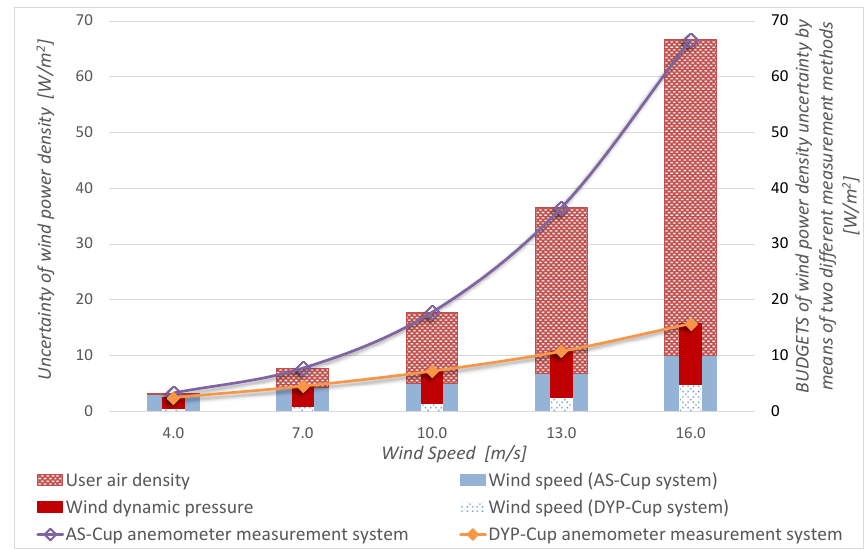
Figure 11. Power density uncertainty budget by means of “power density equations based on wind speed” (AS-Cup, conventional method) and “power density equations based on wind dynamic pressure” (DYP-Cup, alternative method).